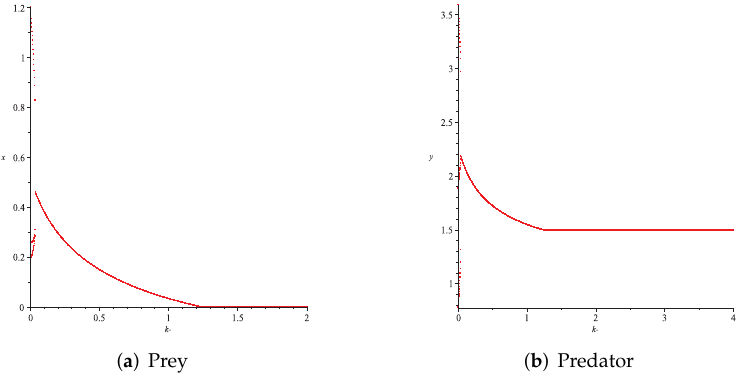
Figure 17. Variation of prey and predator densities with parameter k ( m = 1, r 0 = 3, h =